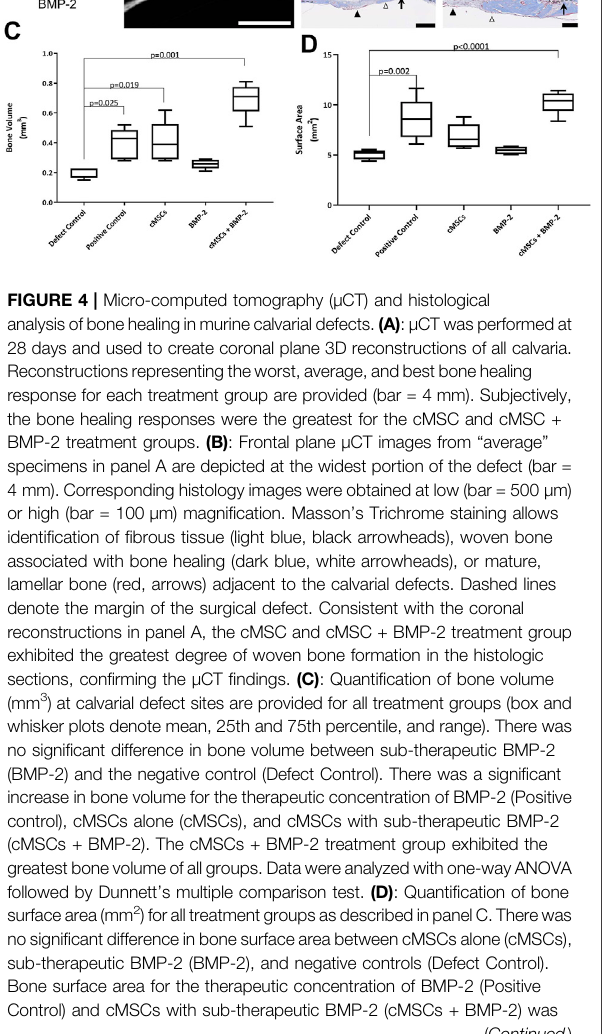
Bone surface area for the therapeutic concentration of BMP-2 (Positive Control) and cMSCs with sub-therapeutic BMP-2 (cMSCs + BMP-2) was